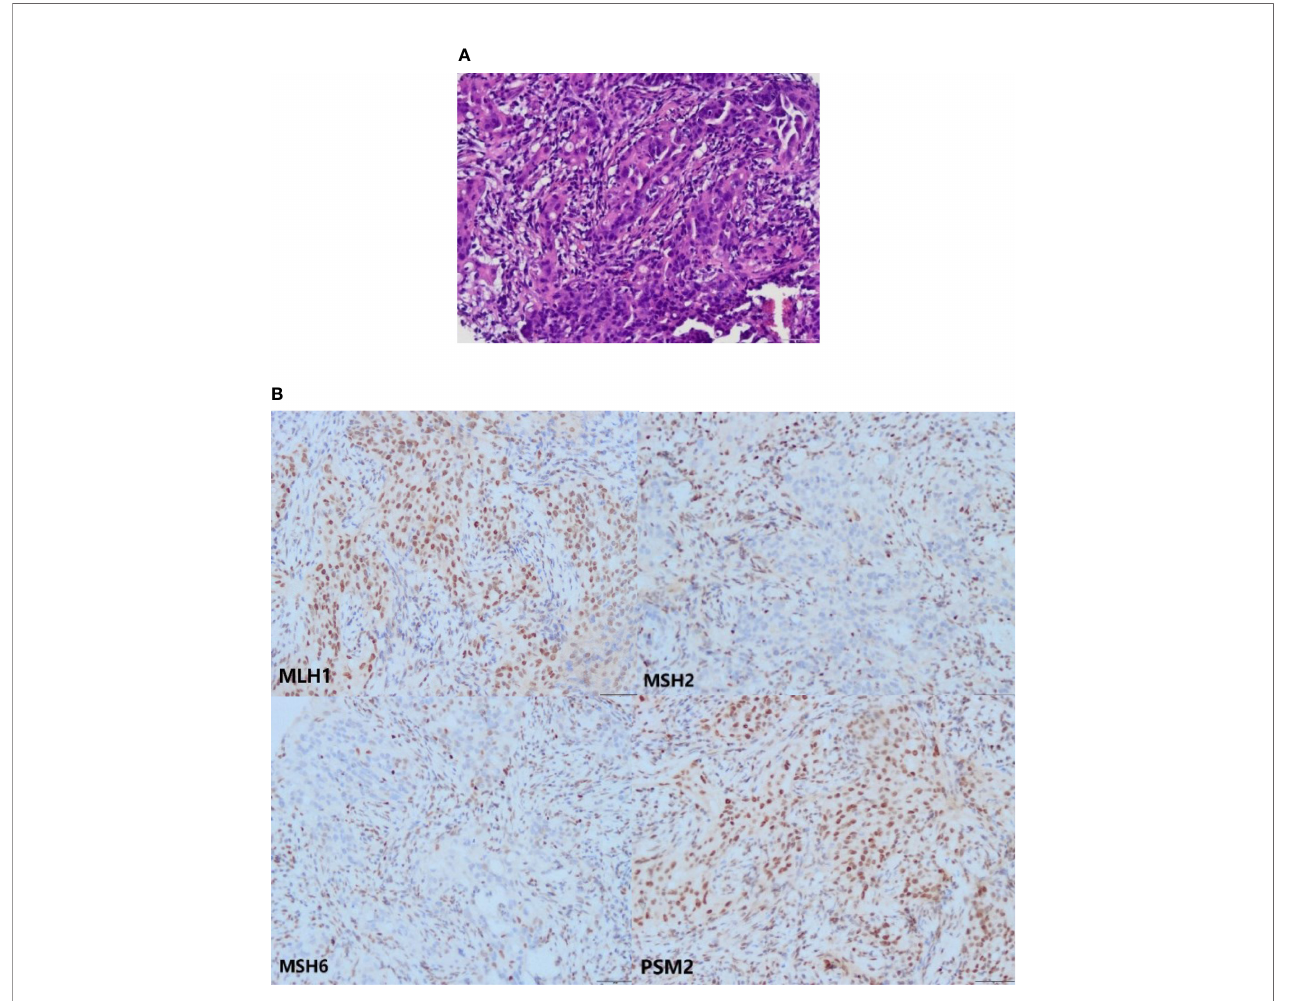
FIGURE 2 | The HE and IHC staining. (A) The HE staining of pelvic mass tissues (the microscope magnifying×200). (B) Loss of MSH2 and MSH6 proteins in the tumor cells. Expression of MLH1 and PSM2 proteins in the tumor cells (the microscope